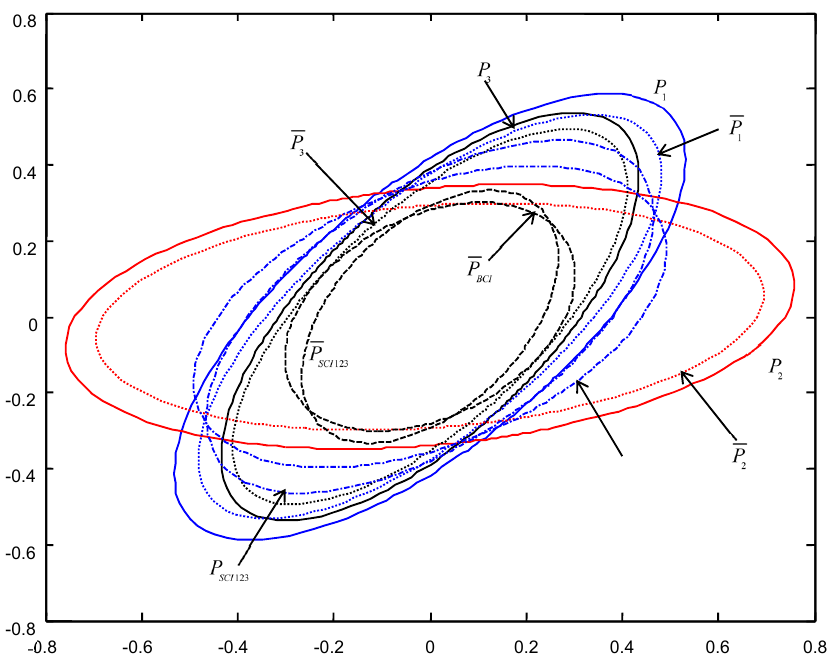
Figure 4. The ellipses of the actual and conservative time-varying filtering error variances of the order SCI 123 at t = 10.